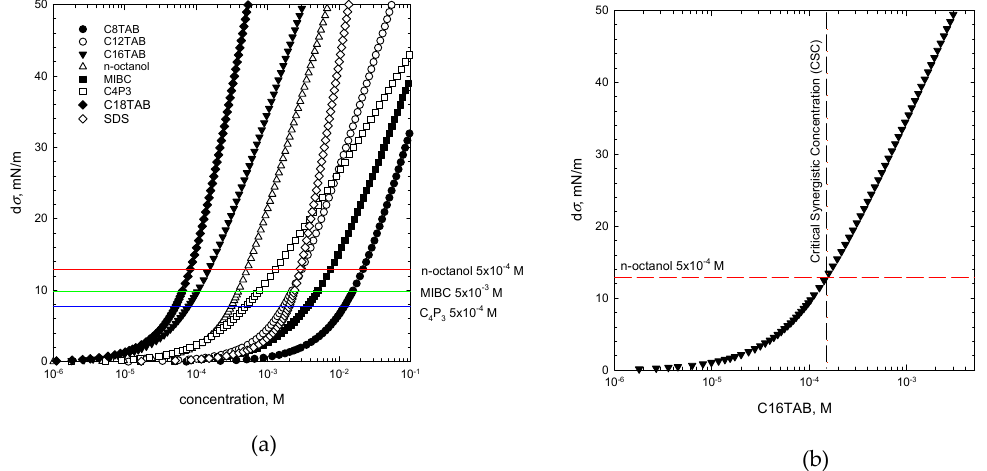
Figure 4. ( a ) The values of d σ calculated for one-component solutions, ( b ) way of determination of the CSC values on the basis of the d σ value (Equation (5)).